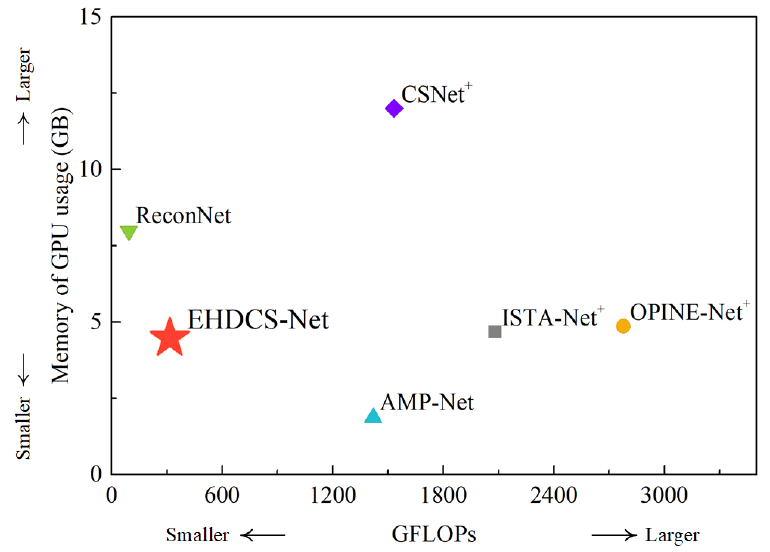
Figure 15. GFLOPs and GPU memory usage comparisons of different deep learning-based image CS methods for reconstructing a large-scene construction site monitoring image (1920 × 1080) in the case of CS ratio = 0.1.